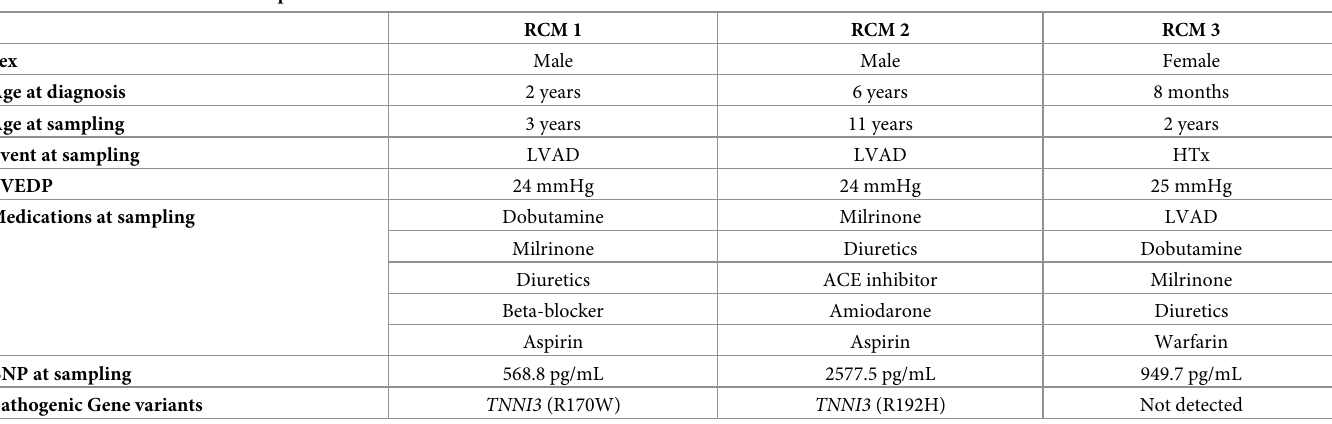
Table 1. Clinical characteristics of